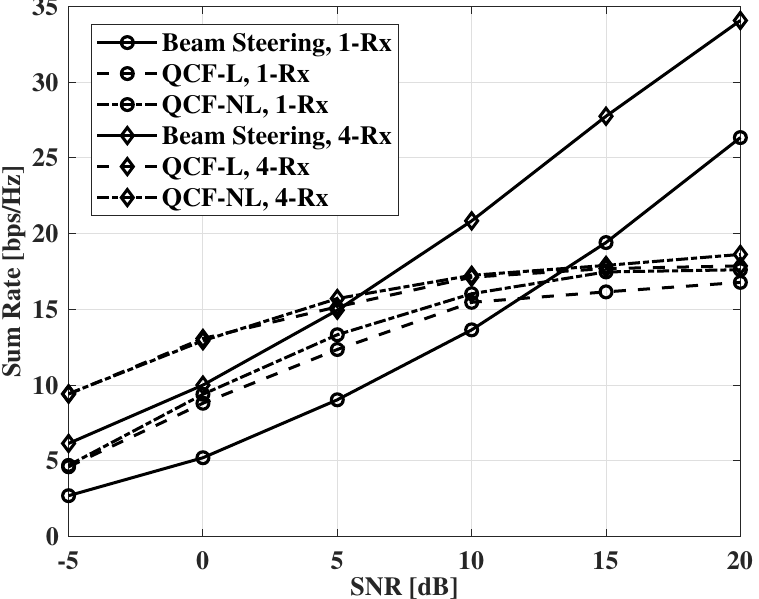
Figure 10. Sum rate measurements according to SNR, codebook size = 8 bits, N t = 64, N RF = 8,4, and N r =